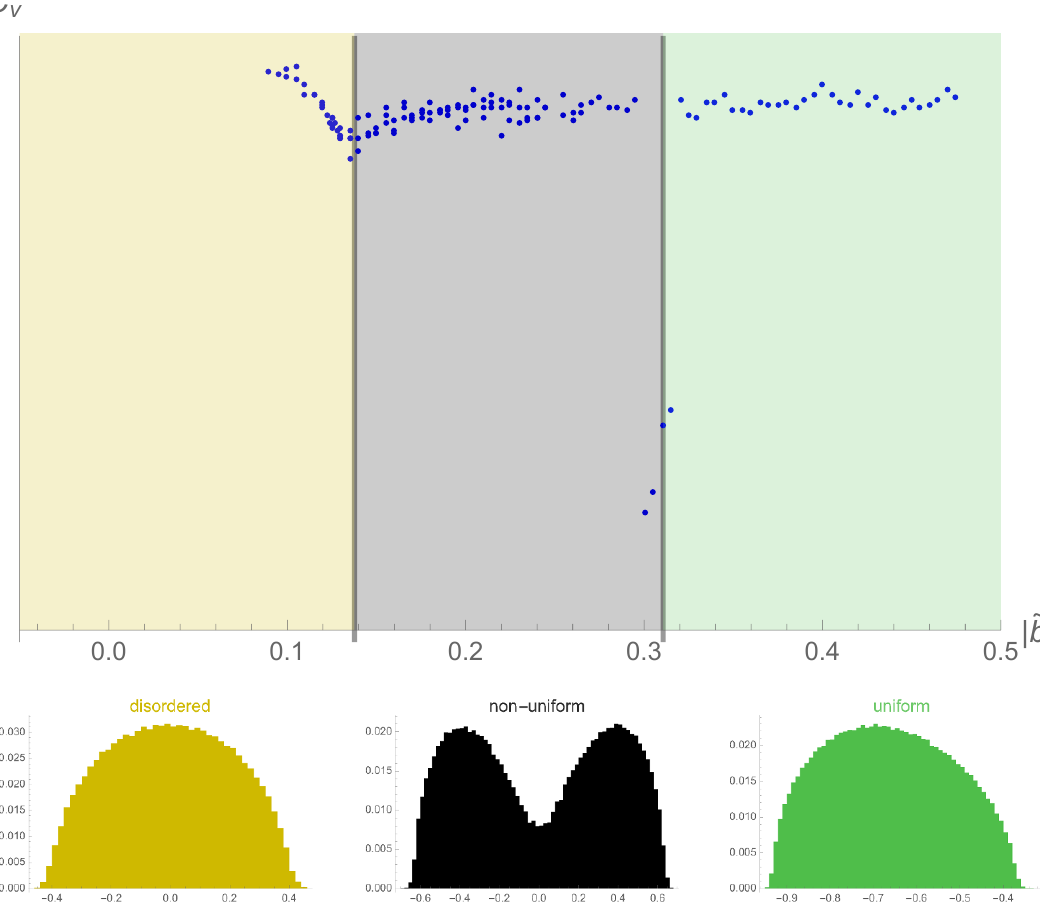
Figure 2 . The top (cid:12)gure shows 1 =C v for N = 64 and a range of ~ b that crosses both transi- tions. Below are shown typical eigenvalue distributions for the respective phases above, where the colour coding is matched in the two (cid:12)gures. The distributions were taken for ~ c = 0 : 05 and (cid:0) ~ b = 0 : 033333 ; 0 : 16667 and 0 : 4 respectively using the last 4000